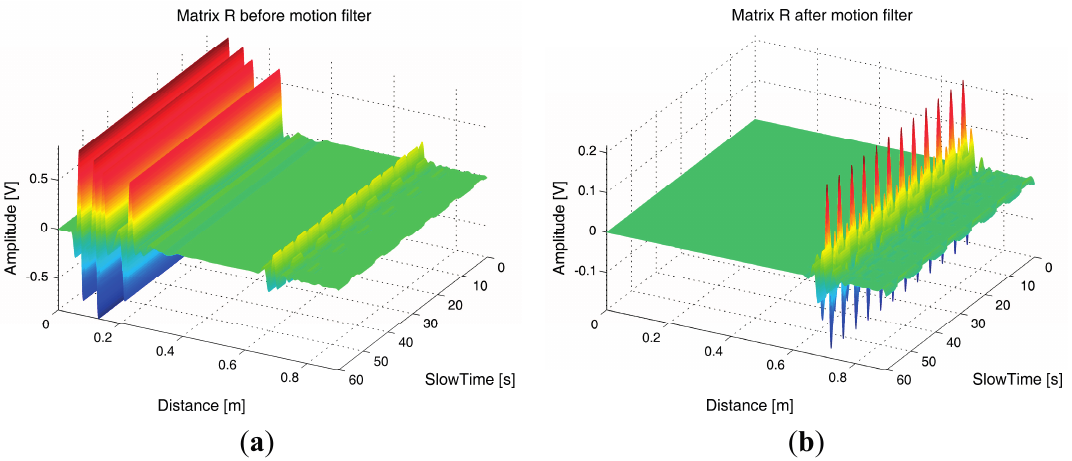
Figure 22. 3-D representation of matrix R in the absence of external EMI sources. ( a ) Before motion filtering; ( b ) After motion filtering.